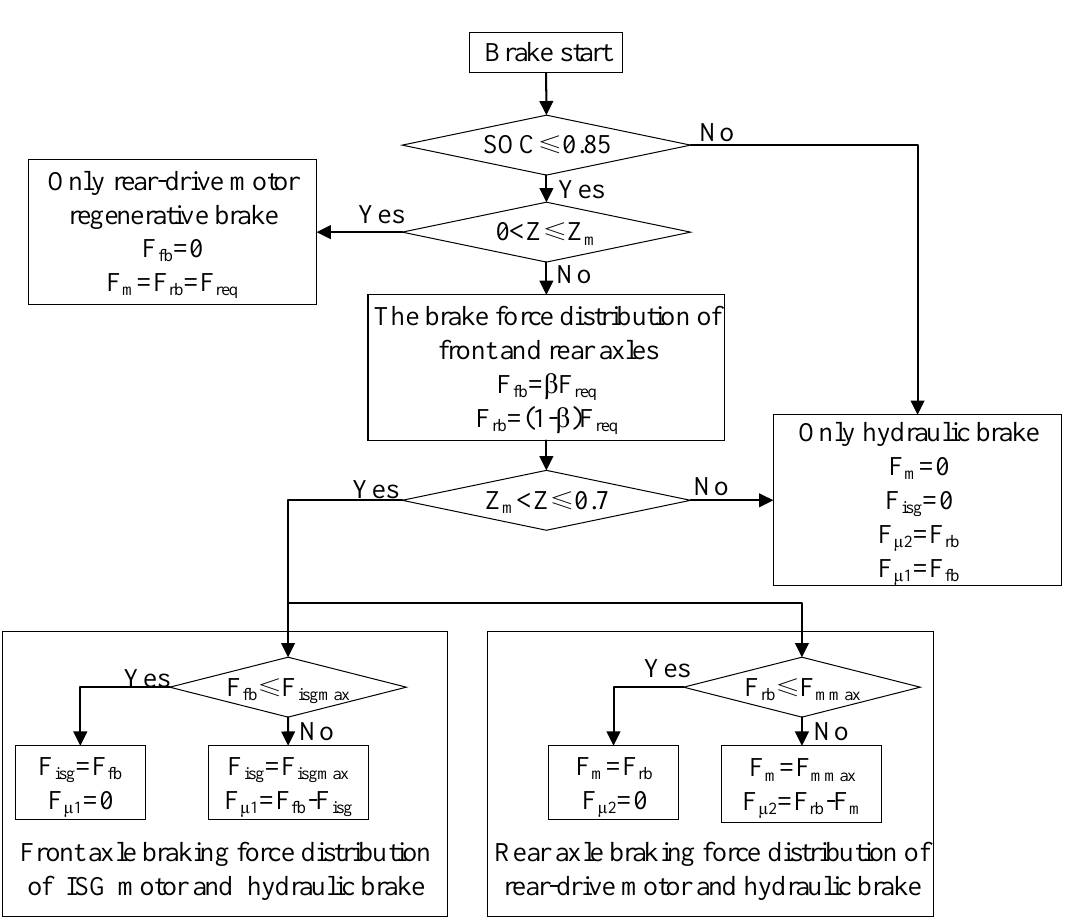
Figure 7. The braking strategy.